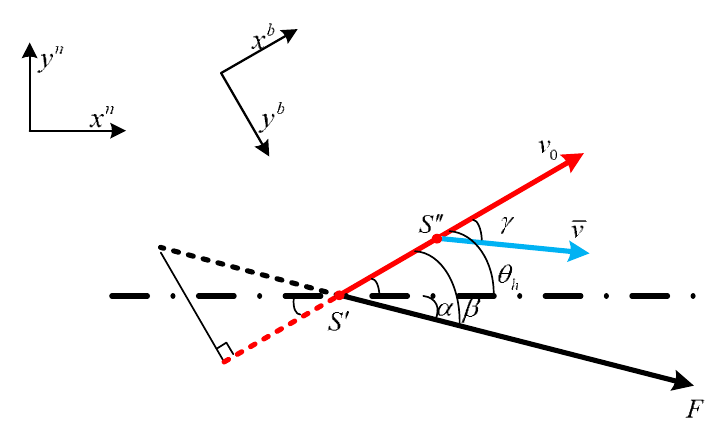
Figure 5. Relationship between the Force and the Velocity